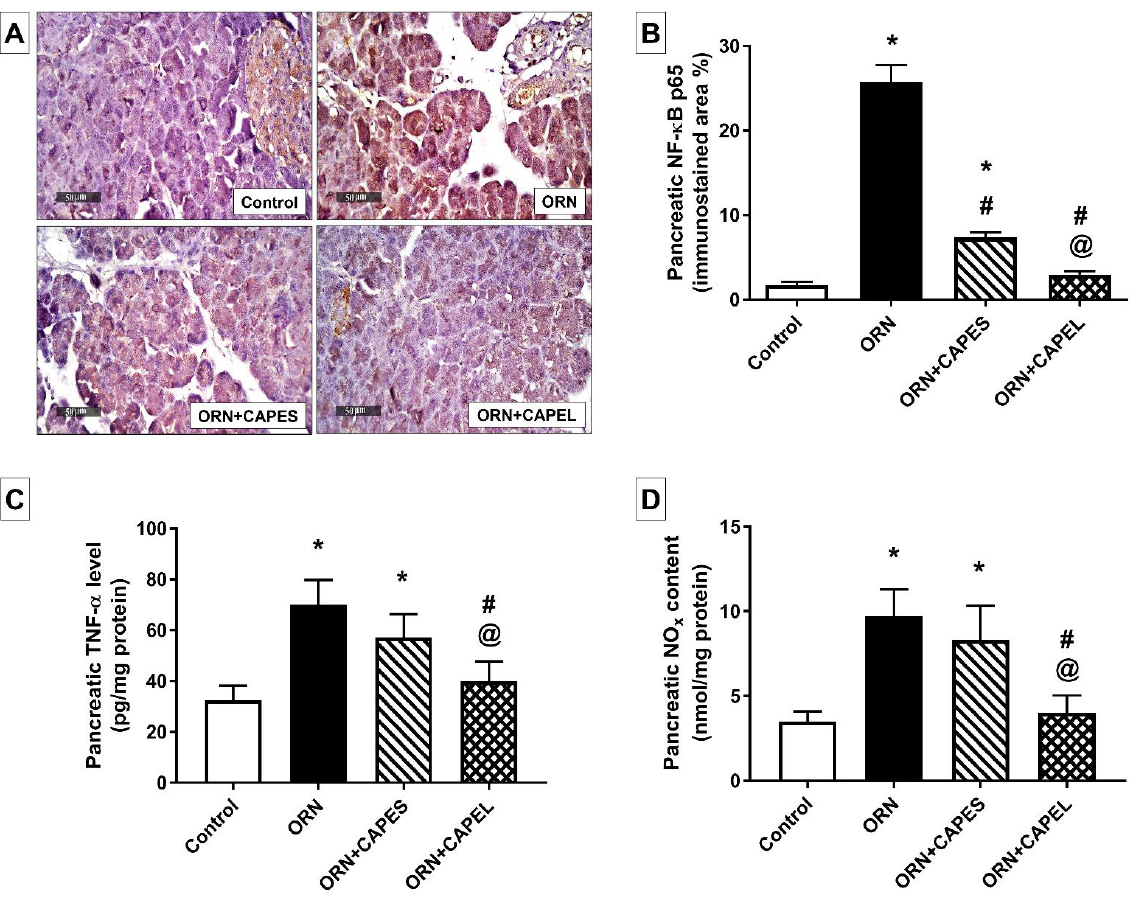
Figure 5. Effect of administering caffeic acid phenethyl ester (CAPE)-optimal liposomal formulation (CAPEL) on pancreatic NF- κ B signaling and inflammatory status in rats with ornithine-induced acute pancreatitis. ( A ) Representative photomicrographs of the immunohistochemical evaluation of pancreatic nuclear factor kappa B (NF- κB ) p65 protein expression in the different study groups (×400 magnification). ( B ) Quantification of NF- κB p65 immunostaining in pancreatic tissue. Values are the